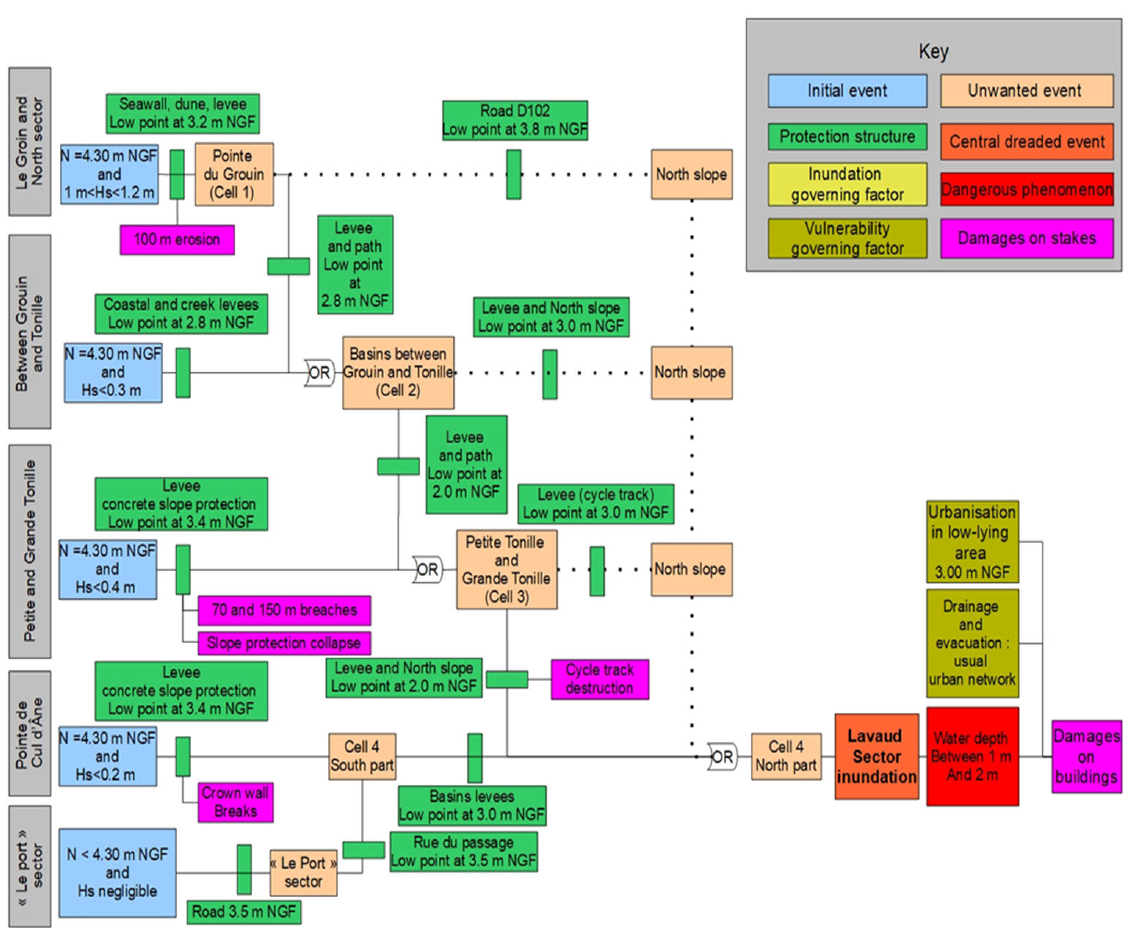
appearing on the “north slope” after the filling of the cells are represented by dotted lines.